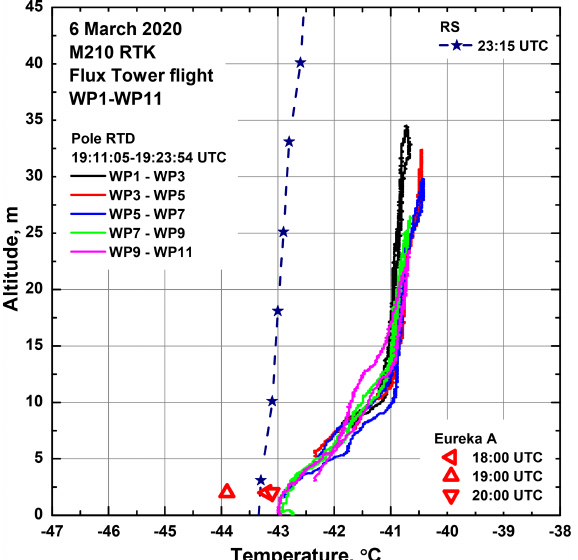
Figure 9. Temperature profiles measured during the M210 RTK flux tower flight along WP1–WP11 waypoints on 6 March 2020. Line colours represent individual profiles in the course of the flight (see Fig. 7 for the locations of the temperature profiles).